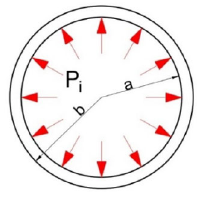
Fig. 2 Schematic of sections of steel